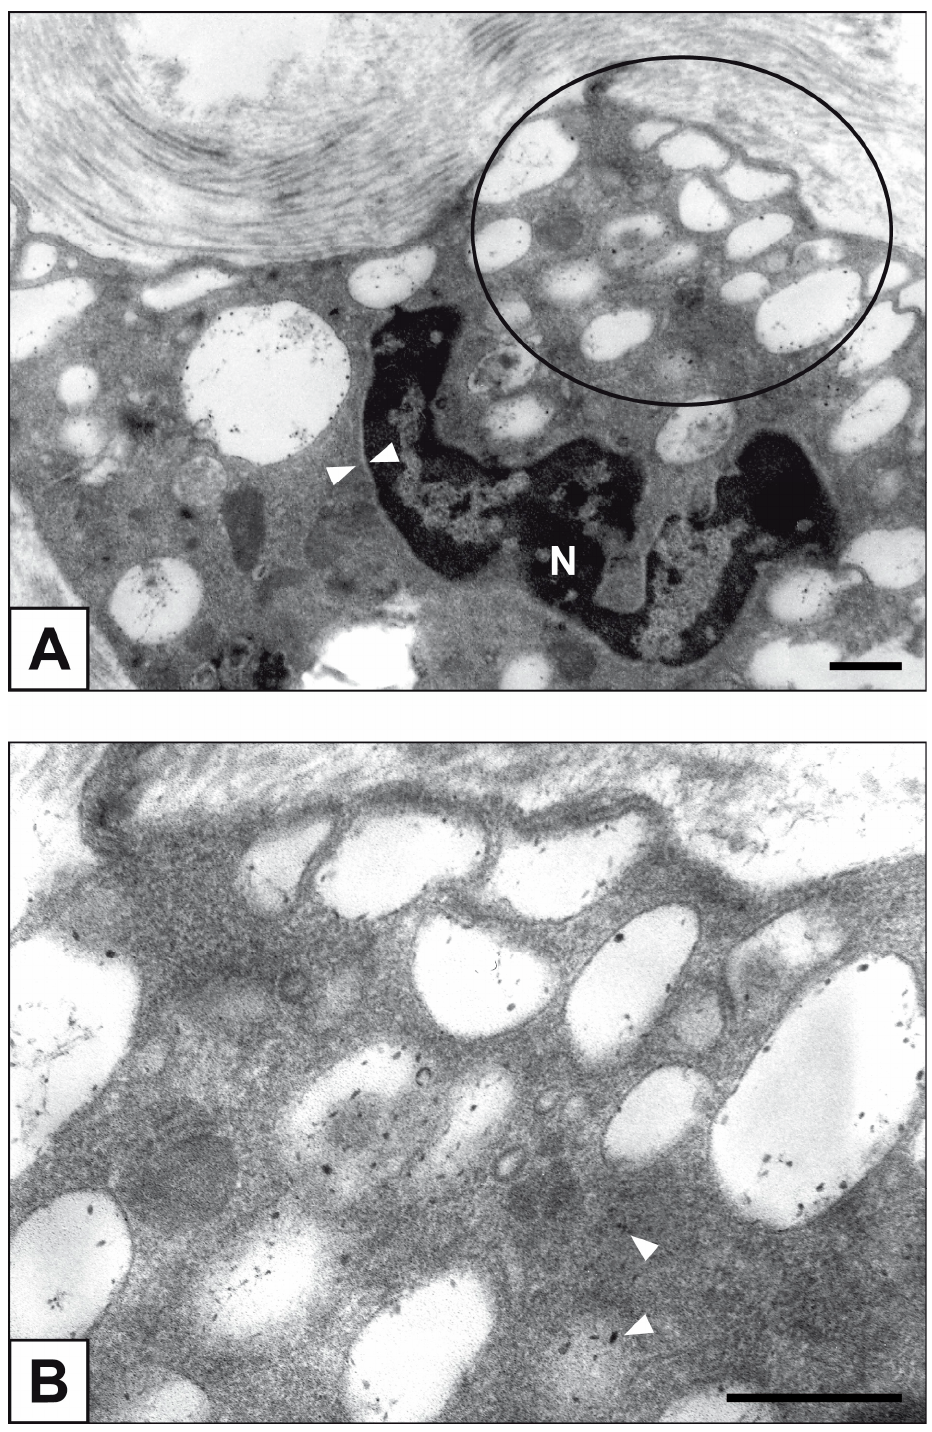
Figure 4. RER ultrastructure in AVICs populating 7-day-long-implanted pAVLs. ( A ) Enlarged RER cisternae (circle) in a mineralizing cell showing electrondense PPM and disappearance of nuclear envelope (counterposed arrowheads; N: nucleus). ( B ) Magnification of the cytoplasm area encircled in ( A ) showing release of ribosomes from dissolving RER membranes and melting with the nearby PPM (arrowheads). Bar: 0.5 μ m.